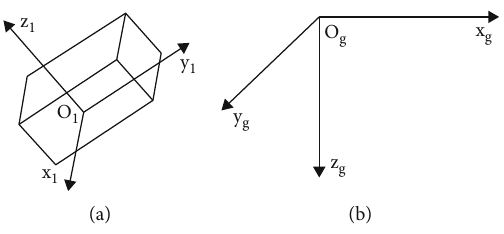
Figure 4: Schematic diagram of coordinate system: (a) sensor motion coordinate system; (b) ground coordinate